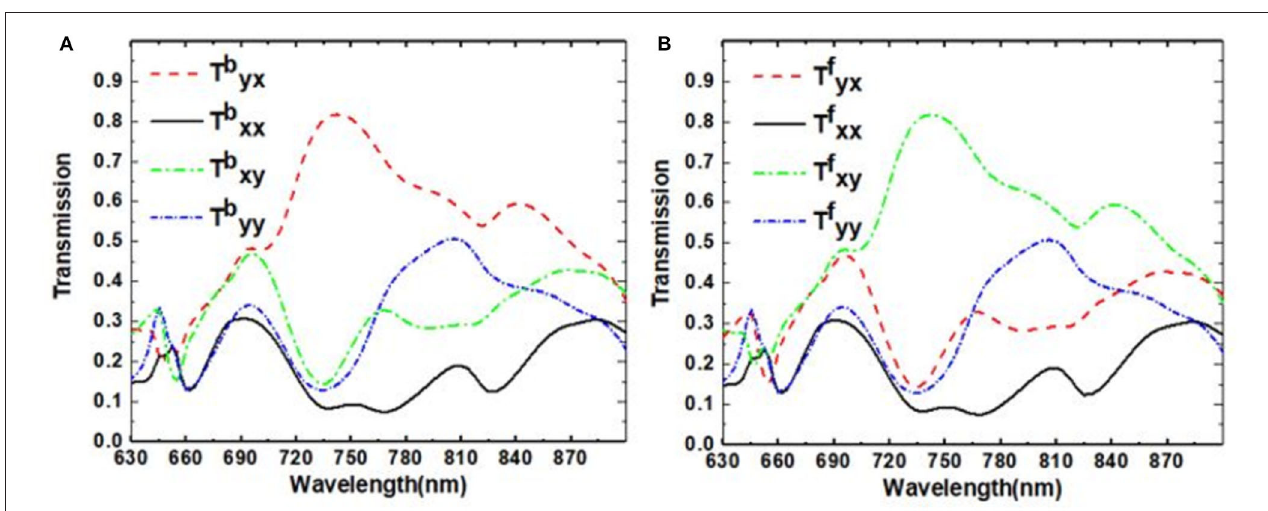
FIGURE 2 | Simulated co- and cross-polarized transmission coefficiency of x - and y - polarizations for (A) backward-propagating (B) forward-propagating light, respectively.